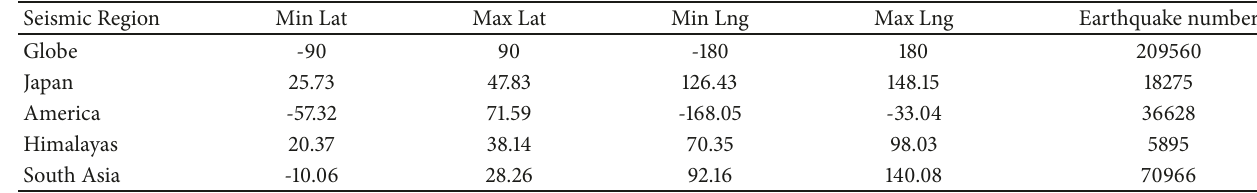
Table 1: Geological range (latitude and longitude) and earthquake event number of the